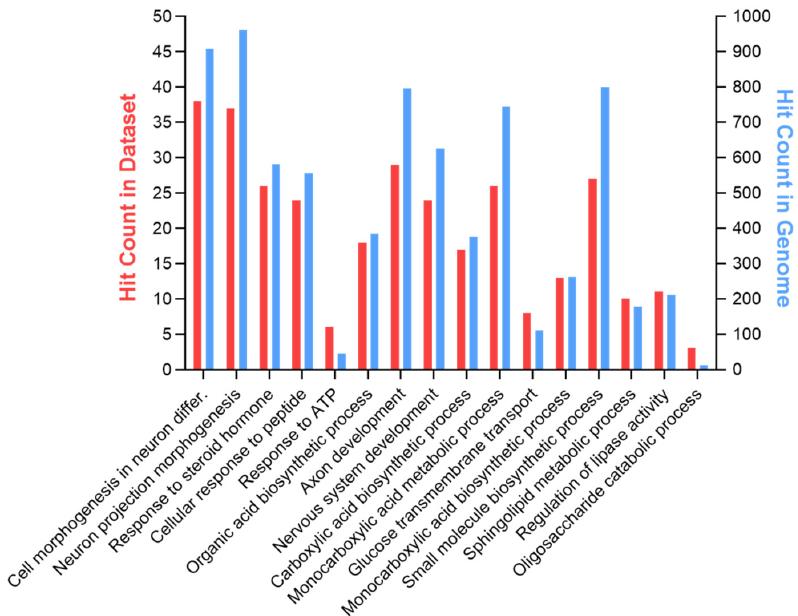
Figure 2. The Toppgene suite has been used to perform a GO-based enrichment analysis on the DEGs. The picture shows some of the significant biological processes related to the central nervous system and cell metabolism potentially altered by GPR17 silencing. Blue bars indicate the total genes associated to each term; red bars indicate the genes in common with our dataset for each term. The complete list of biological processes resulting from this analysis and the relative p -values are reported in Table